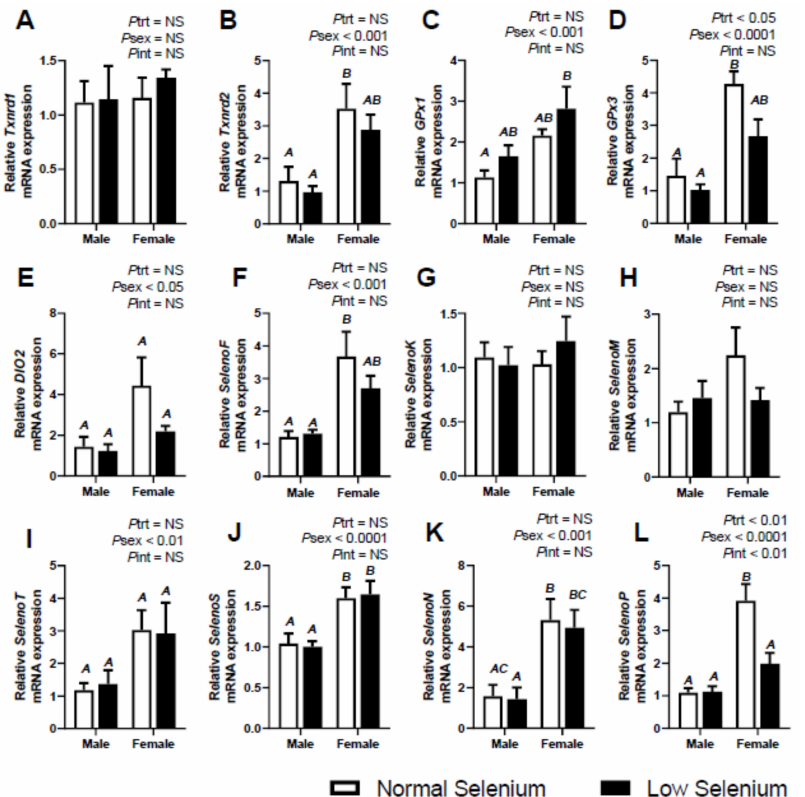
Figure 6. E ff ects of selenium deficiency on selenoprotein expression in o ff spring hearts at PN180. Expression in male and female o ff spring hearts, at PN180, of; ( A ) thioredoxin reductase 1, ( B ) thioredoxin reductase 2, ( C ) glutathione peroxidase 1, ( D ) glutathione peroxidase 3, ( E ) deiodinase 2, ( F ) selenoprotein F, ( G ) selenoprotein K, ( H ) selenoprotein M, ( I ) selenoprotein T, ( J ) selenoprotein S, ( K ) selenoprotein N and ( L ) selenoprotein P. Data are mean ± SEM and analysed by two-way ANOVA with treatment ( P trt ) and sex ( P sex ) as major factors. P int represents the interaction between treatment and sex. Significance was determined as p < 0.05. If a major e ff ect of treatment, sex or an interaction between treatment and sex was identified, then a Sidak posthoc test was performed. Significant di ff erences between groups as detected by posthoc analysis are denoted by di ff erent letters where “A” is di ff erent from “B” which is di ff erent from “C”. “A” is not di ff erent from “A” or “AB”, while “B” is not di ff erent from “B”, “AB” or “BC”. The groups are Normal male, n = 8 (8 animals from 8 separate litters); Low male, n = 8 (from 8 separate litters); Normal female, n = 8 (from 8 separate litters); Low female, n = 6 (from 6 separate